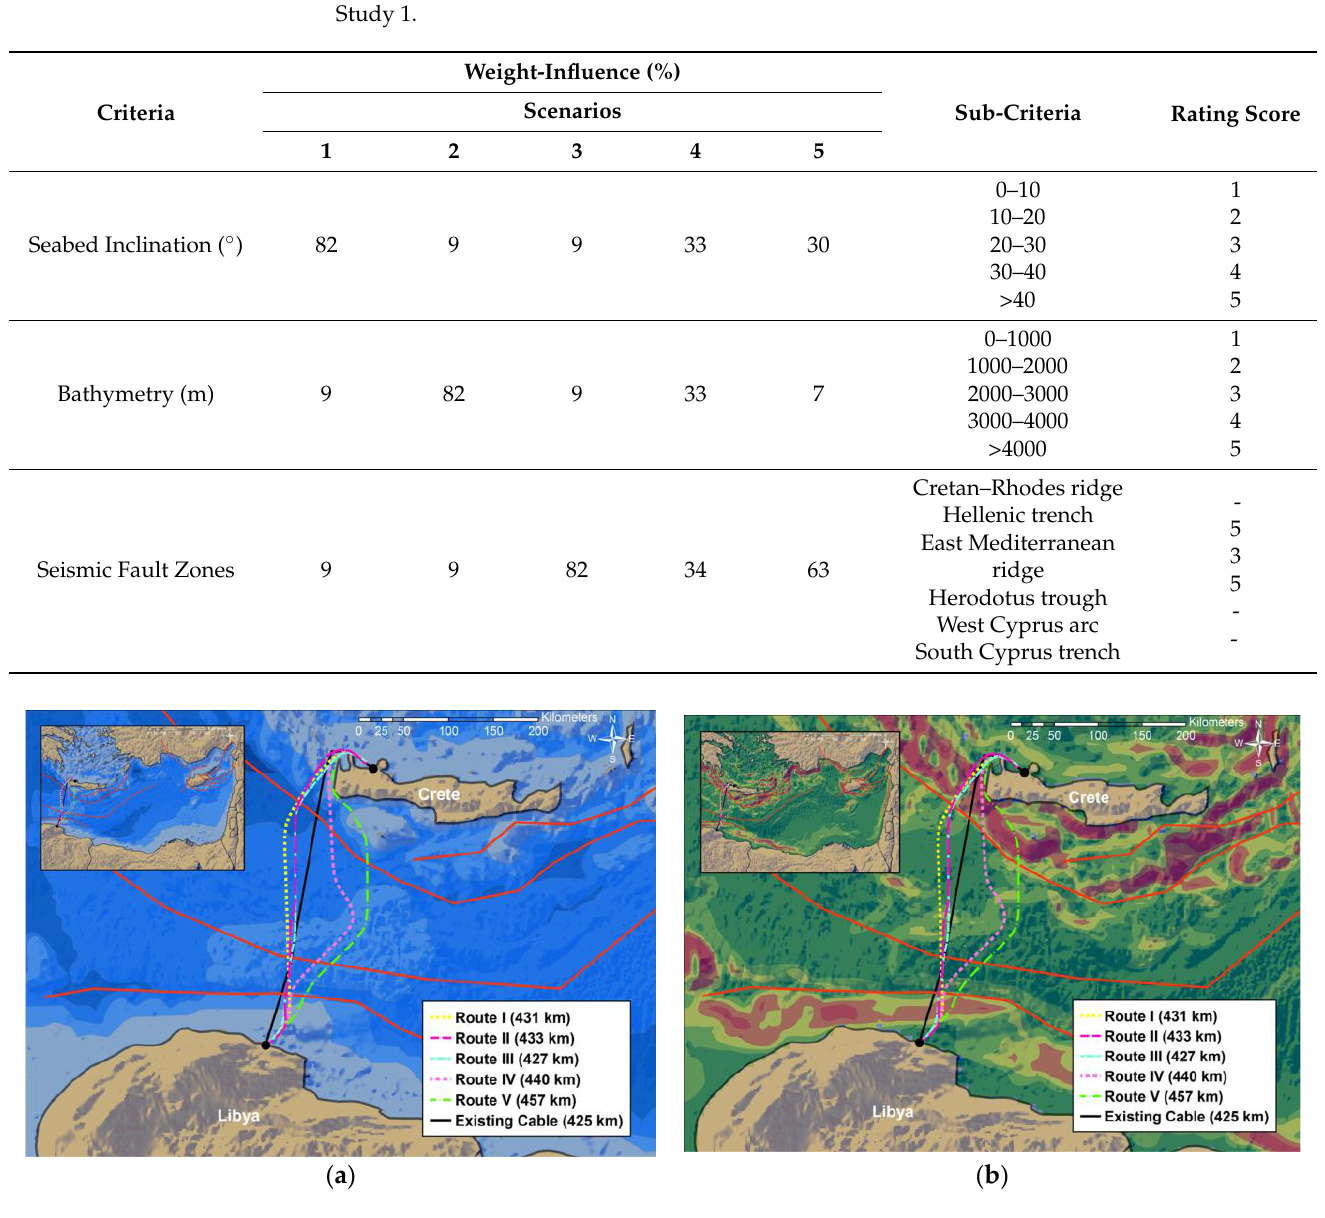
Figure 10. Proposed alternative routes and seismically active fault zones: ( a ) with the bathymetry as a background and ( b ) with the seabed inclination as a background.